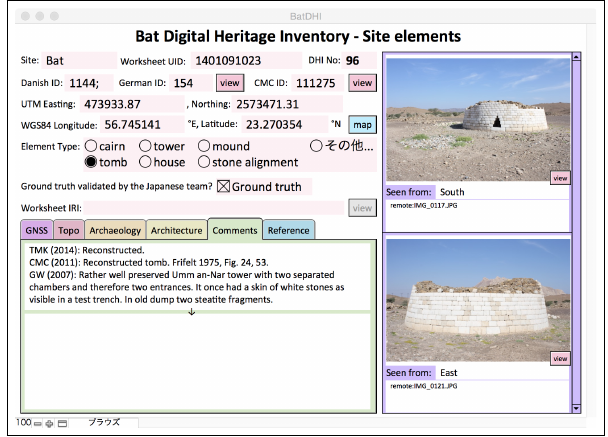
Figure 8: Interface of the ElementDHI table (Comments tab). strictly controlled. One or more values are selected from the list (Paleolithic, Holocene Pre-Hafit, Hafit, Umm an-Nar, Wadi Suq, Iron Age, and Islamic).